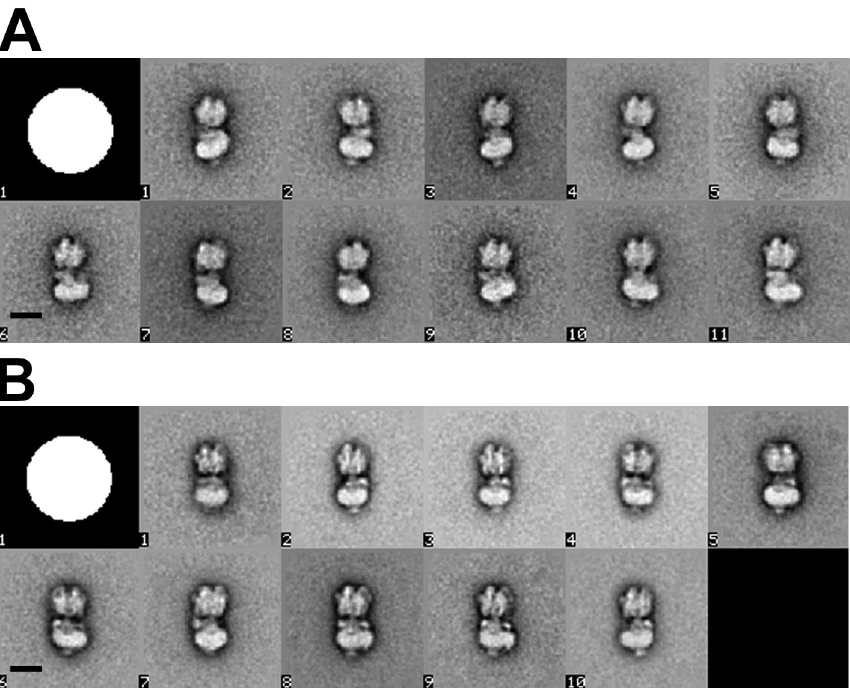
Figure 4. The influence of ATP on V-ATPase flexibility. The classes which represented the most degree of flexing between V and V for the M - sexta V-ATPase in the absence (A) and presence (B) of 5mM ATP. All data were aligned to the same references o and classified in Imagic-5, using the circular mask shown in the top right corner. The Scale bar represents 150Å. The full set of 100 classes from which these were extracted are shown in Figure